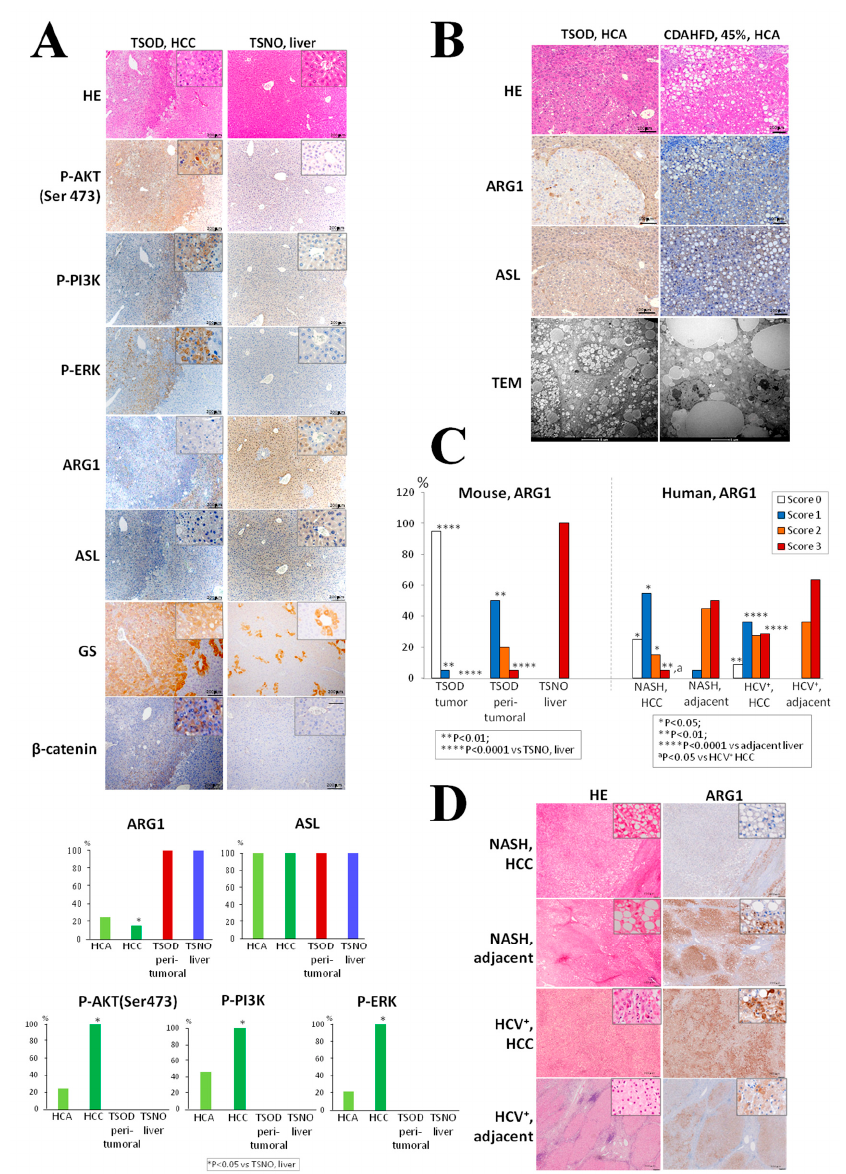
Figure 4. Representative pictures and quantitative immunohistochemical analysis of P-AKT (Ser473), P-PI3K, phospho-ERK1 / 2 (P-ERK), arginase 1 (ARG1), argininosuccinate lyase (ASL), glutamine synthase (GS) and β -catenin in TSOD mice HCCs ( A ). P-AKT(Ser 473), P-PI3K, P-ERK1 / 2, and GS were strongly overexpressed in the HCCs of TSOD mice. ARG1, ASL expression, and TEM findings in TSOD and 45% choline-deficient, L-amino acid-defined high-fat diet (CDAHFD)-treated mice HCAs (42-weeks) ( B ). Note significant suppression of ARG1 and slight decrease of ASL expression in TSOD, but high expression in 45% CDAHFD-treated mice HCA, lipid degeneration, and ballooning of TSOD mice, and accumulation of large size lipid droplets in 45% CDAHFD-treated mice tumors. ARG1 and ASL were highly expressed in the livers of C57Bl / 6J control age-mached littermates, peri-tumoral, and tumor tissues of CDAHFD-treated mice. Immunohistochemical findings for ARG1 in mouse and human livers and HCCs ( C ). Note strong inhibition of AGR1 expression in TSOD mouse tumors and nonalcoholic steatohepatitis (NASH) HCCs. AGR1-negative and positive cases of NASH-associated and HCV + human HCCs, respectively ( D